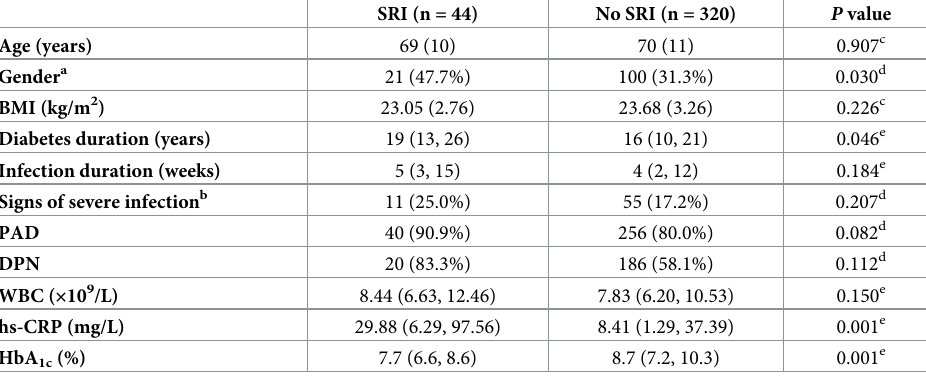
Table 2. Univariate analysis between patients with and without